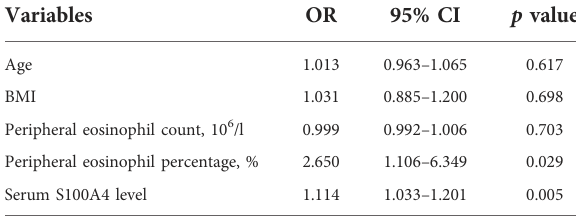
TABLE 3 Logistic regression analysis of factors affected the rate of recurrence in CRSwNP patients.